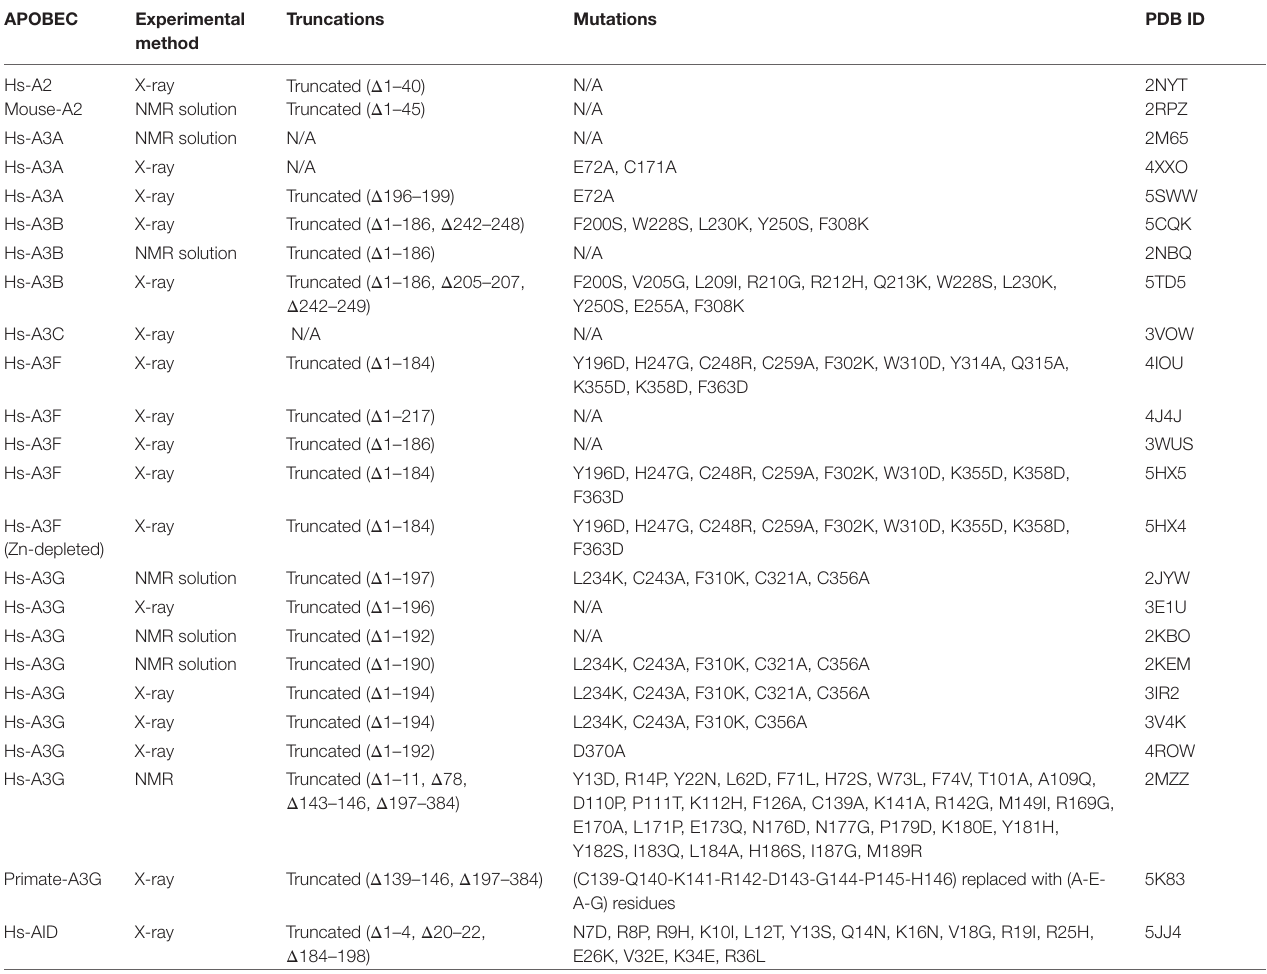
TABLe 1 | All X-ray and nMR solution structures of the APOBeC